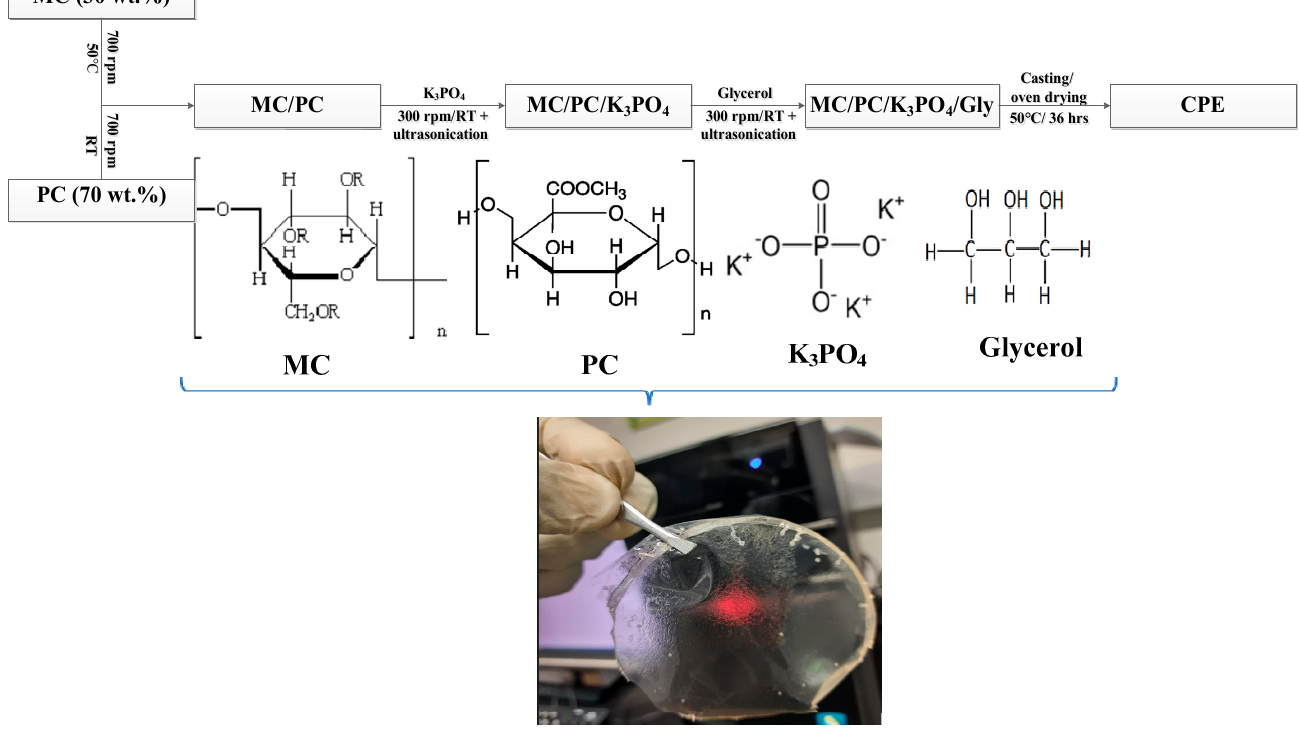
Figure 8. A schematic diagram describing the synthesis of